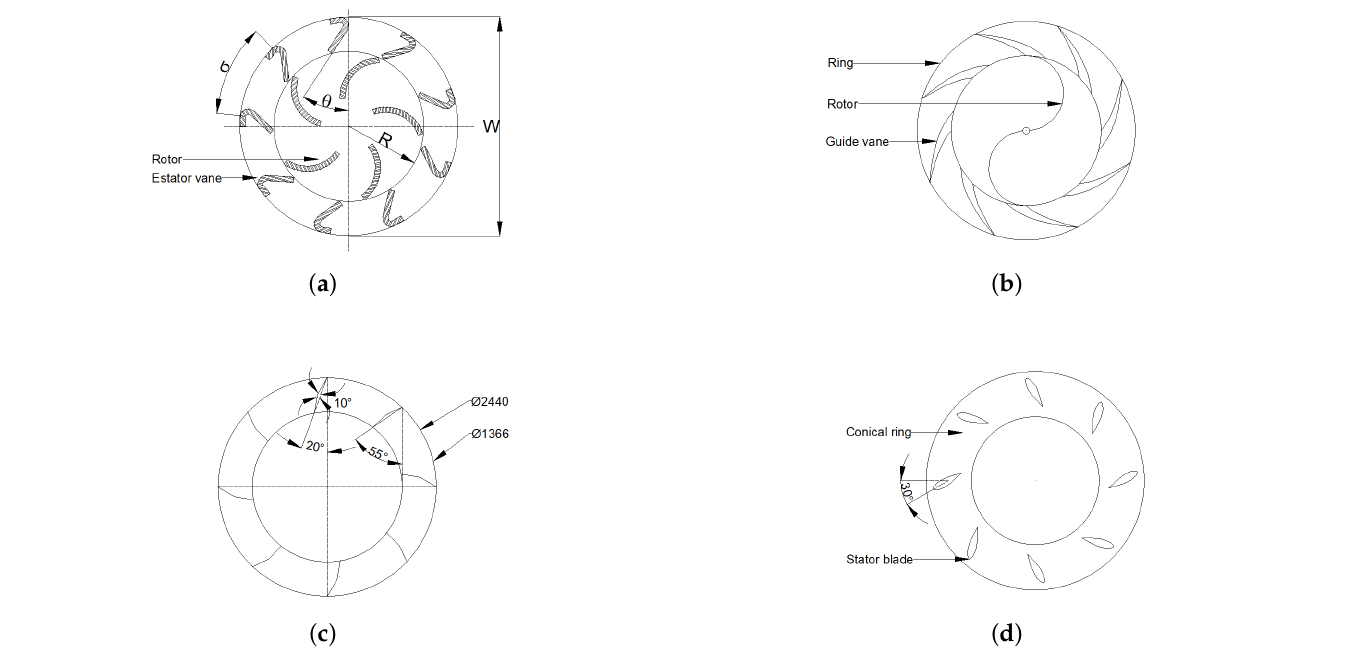
Figure 1. Different omni-directional wind boosters. ( a ) Geometrical variables of Zephyr VAWT. ( b ) Korprasertsak et al. Savonius with wind booster. ( c ) Wong et al. ODGV design. ( d ) Nobile et al. 3D stator.